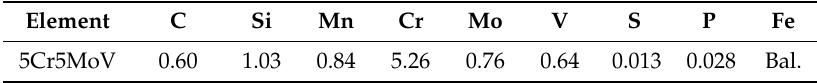
Table 1. Chemical composition of 5Cr5MoV die steel (wt.%).